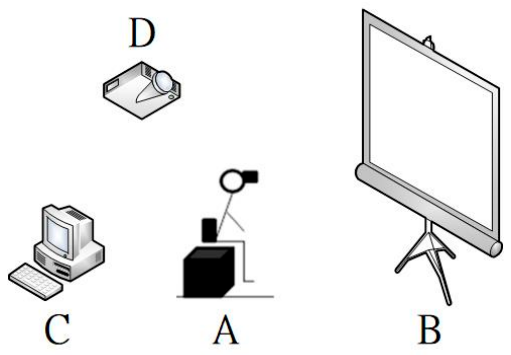
Figure 1. Experimental setup (( A ) eye tracker, ( B ) projection screen, ( C ) investigator control com- ( D ) puter, ( D ) projector).